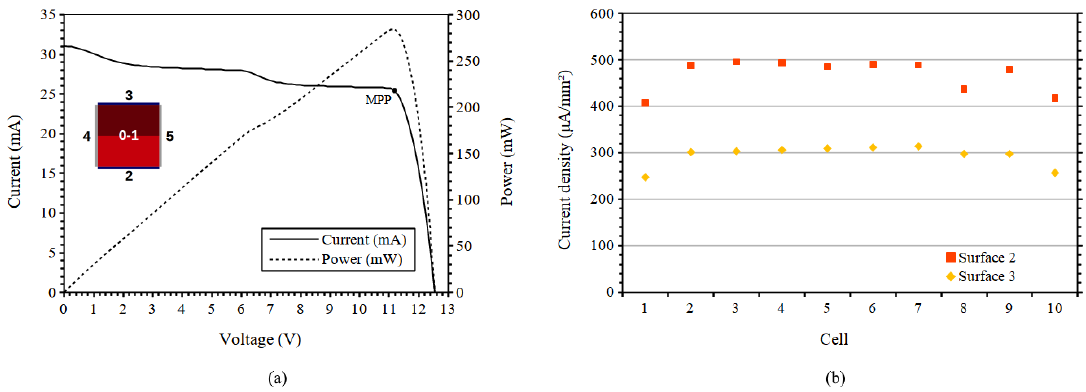
Figure 24. Shaded LSC panel with two 10-cells PV arrays, shading along the PV arrays: ( a ) characteristic curves (I-V and P-V), ( b ) current density produced by each PV cell.